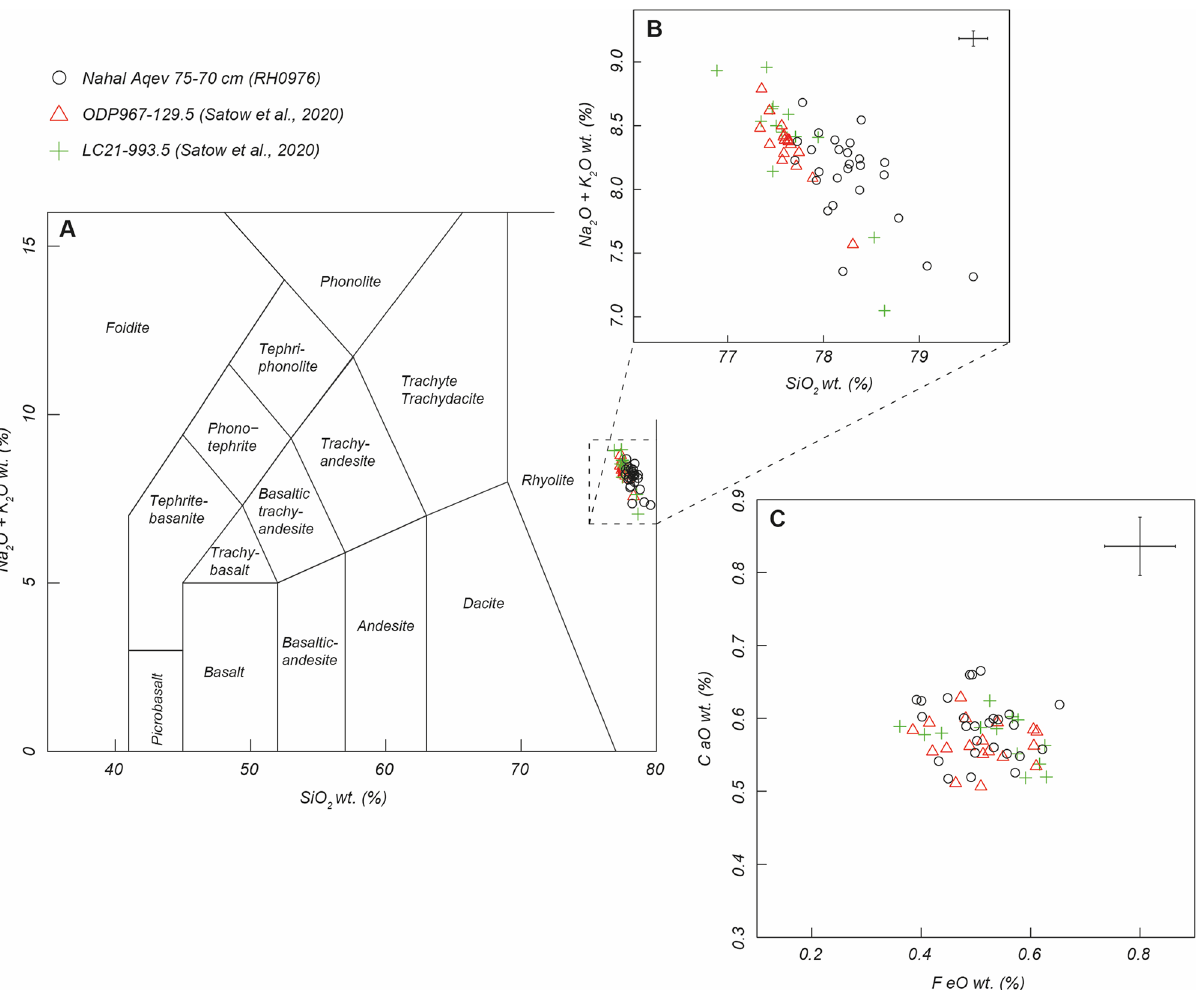
Figure 5. Geochemical composition of the Nahal Aqev tephra and correlation to MIS 5e, Sapropel S5 tephra from ODP-967 and LC-21 (values normalized on water free basis). ( A ) Total Alkali Silica (TAS) classification based on Le Bas et al. 64 , ( B ) inset of TAS plot, ( C ) FeO vs CaO wt. (%). Error bars represent 2 SD of replicate analyses of Lipari glass standards (Table S6.2). Additional geochemical plots demonstrating a clear correlation on all Oxides is available in SI Appendix, Fig. S6.1. Figure 5 was prepared by R. Timms and S.